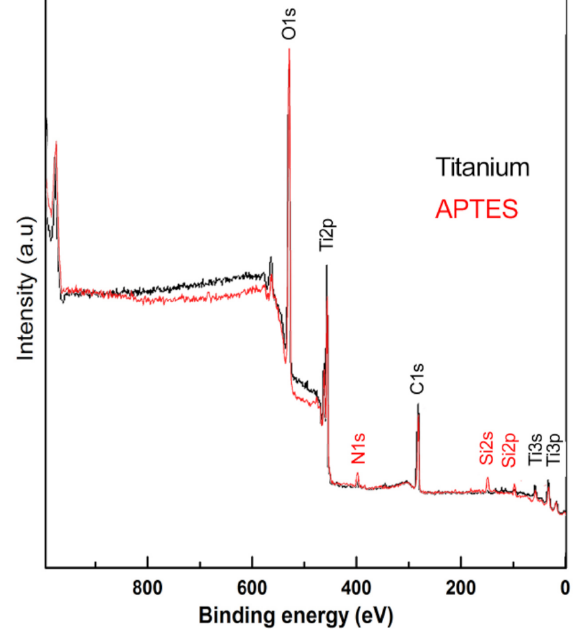
Figure 3. XPS spectra of the Ti (black line) and APTES-coated (red line) surfaces.